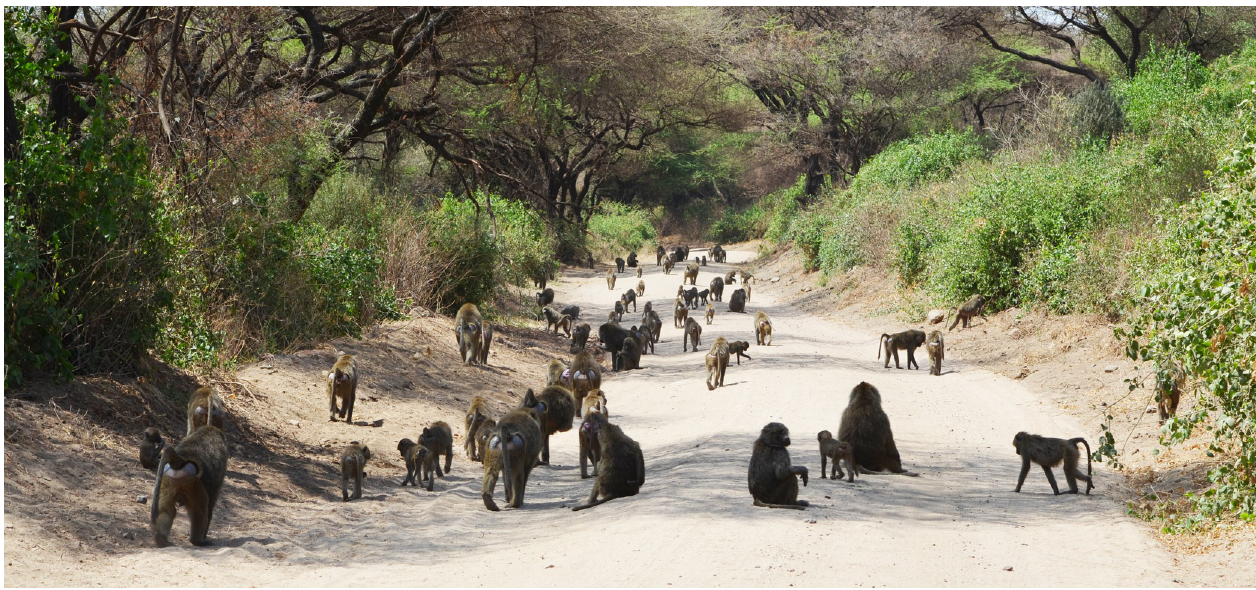
Fig 1. Part of an olive baboon ( Papio anubis ) group using a road in Lake Manyara National Park, Tanzania (Photo: Filipa M.D. Paci ê ncia).